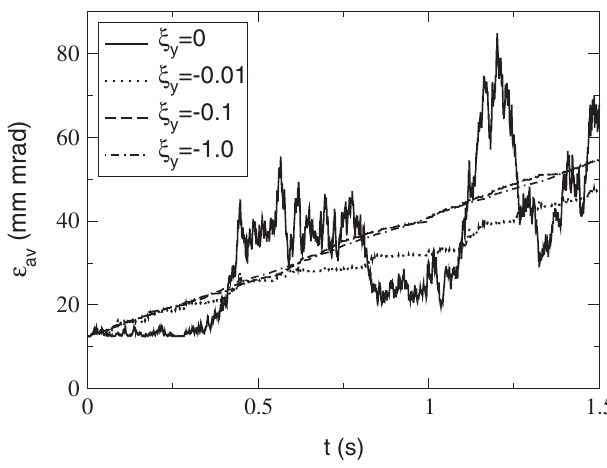
FIG. 1. Time evolution of the beam emittance calculated using the parameters from Table II depending on the chromaticity (cid:12)